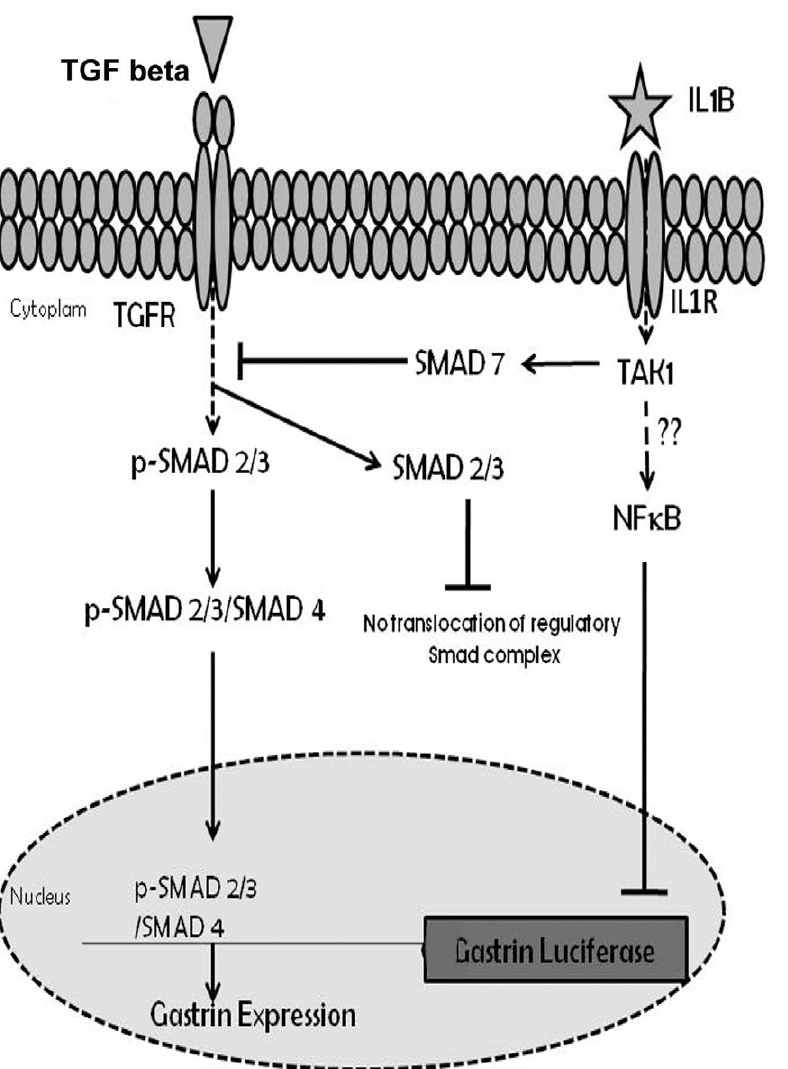
Figure 7. IL1B activates two different pathways having a cumulative effect on Gastrin repression. Stimulation with IL1B results in an increase in Smad7 levels which inhibits the TGF-beta pathway by blocking the nuclear localization of the regulatory Smad 2/3/4 complex. On the other hand, IL1B also activates the NFKB pathway which plays a direct role in repression of the gastrin gene expression. Dotted arrows represent pathways that are yet to be established.